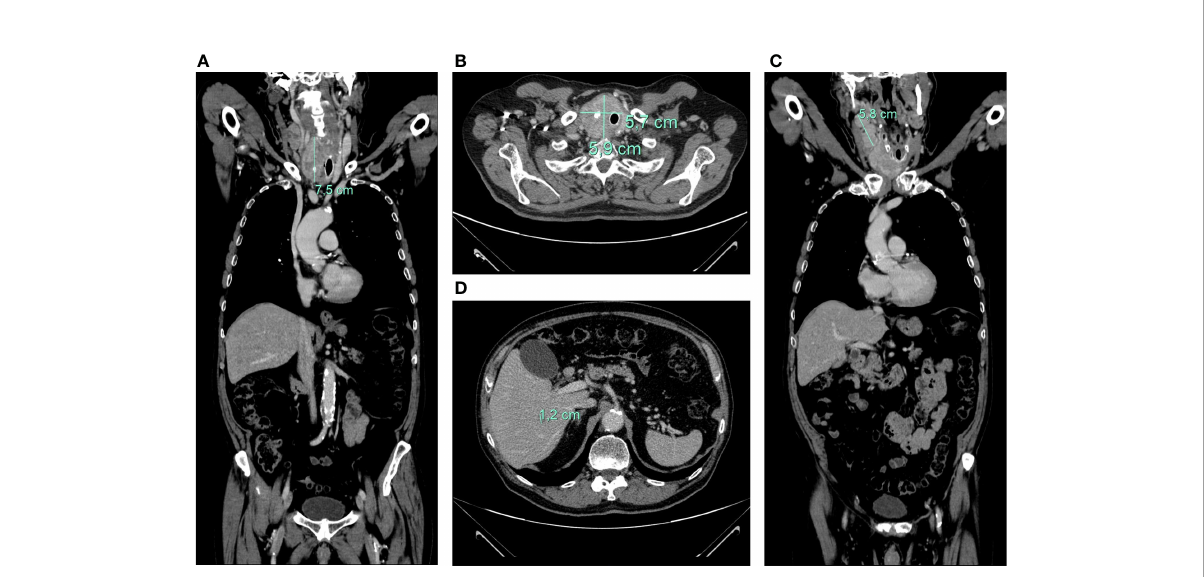
FIGURE 2 axial (A) and coronal (B) CT-scan showing large inhomogeneous tumor with calci fi cations of the right thyroid lobe with left tracheal displacement, in fi ltrating the trachea and esophagus; con fl uent neck lymph node metastases (maximum diameter of 58 mm) (C) ; hepatic lesion of 12 mm at V segment (D)